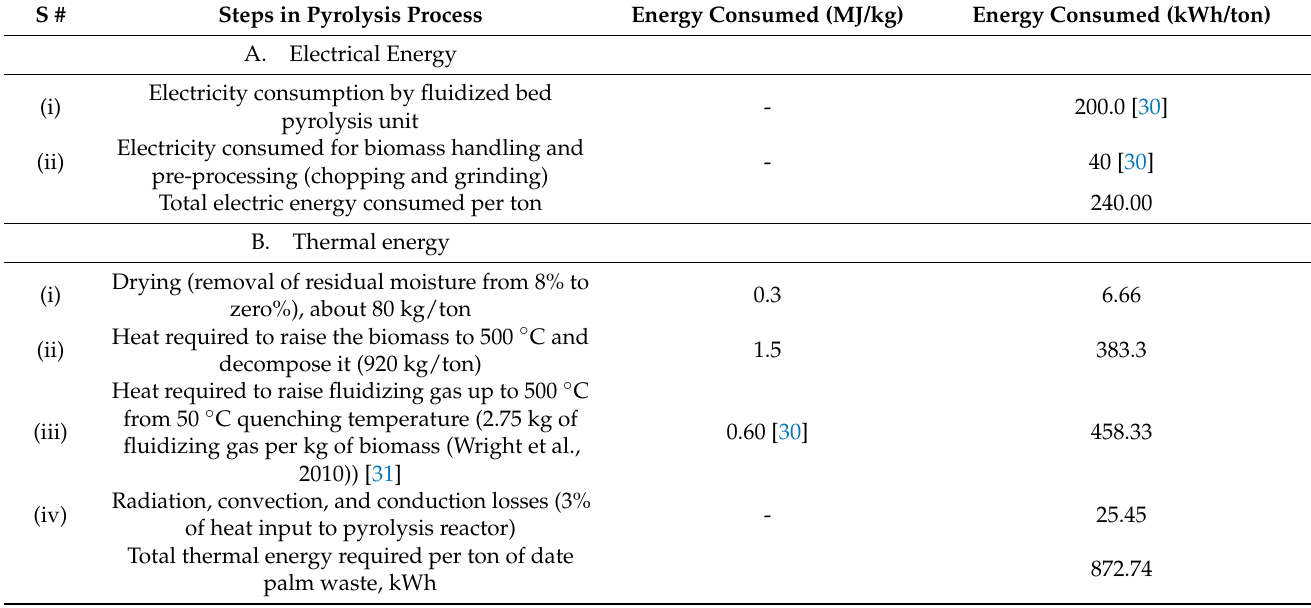
Table 3. Energy consumed in pyrolysis